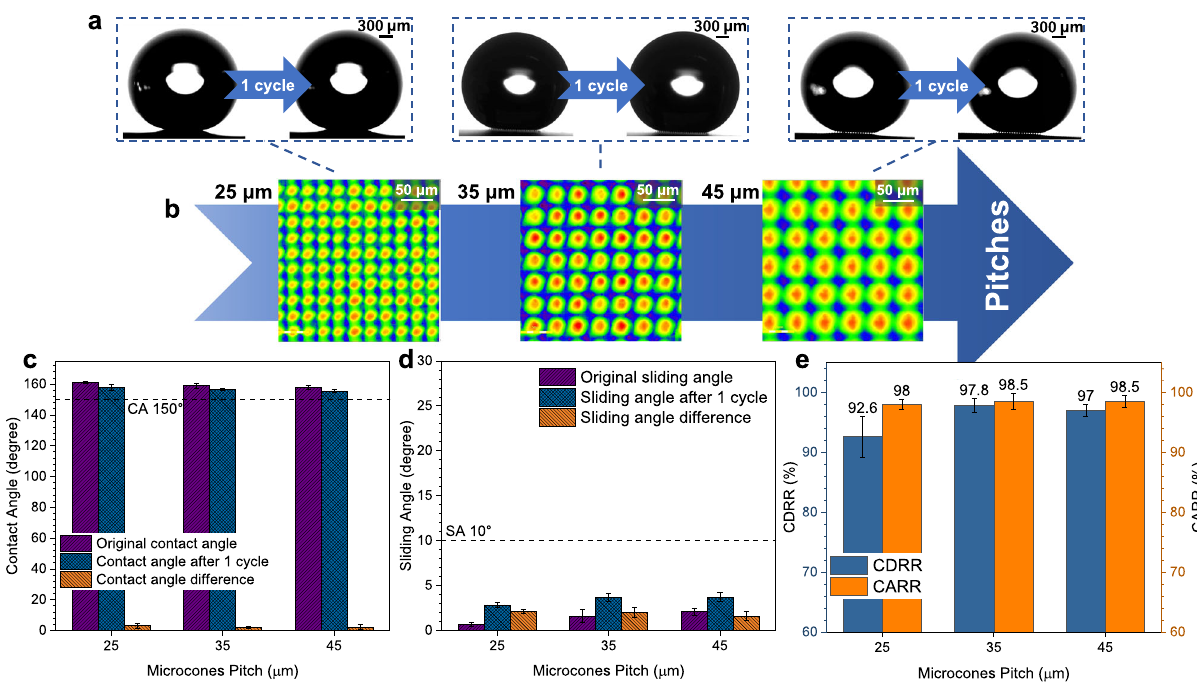
Fig. 9 Effects of different microcones pitches on the recovery of CB state. a State changes of droplets on the MCNP surfaces with different microcones pitches after an icing & melting cycle. b Morphology evolutions of micro-nanostructure with different microcones pitches. Microcones height is fi xed at 45 μ m while microcones pitches vary from 25 μ m to 45 μ m. c – e Effects of different microcones pitches on the contact diameter recovery rates (CDRR), the contact angle recovery rates (CARR), contact angles (CA), and sliding angles (SA), respectively. The CA 150° and SA 10° boundaries of superhydrophobicity are indicated with the black dashed line. Data are mean ± s.d. from at least three independent measurements.